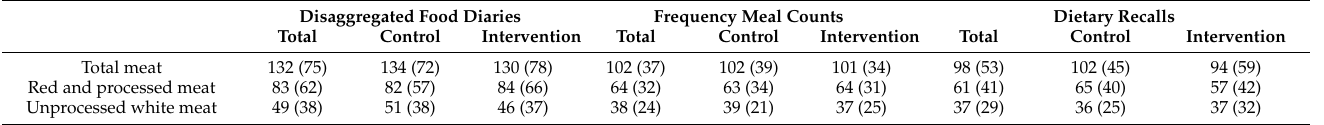
Table 2. Baseline meat consumption (g/day).